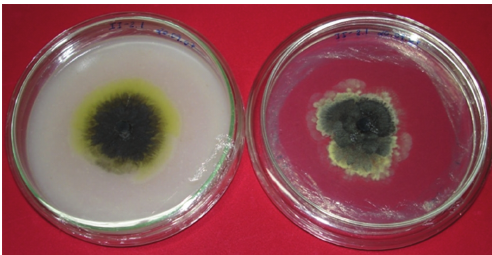
Figure 1: Aspects of G. citricarpa colony morphology in oat- meal medium (left), showing the yellow halo, characteristic for pathogenic isolates, and its aspect on PDA medium, without